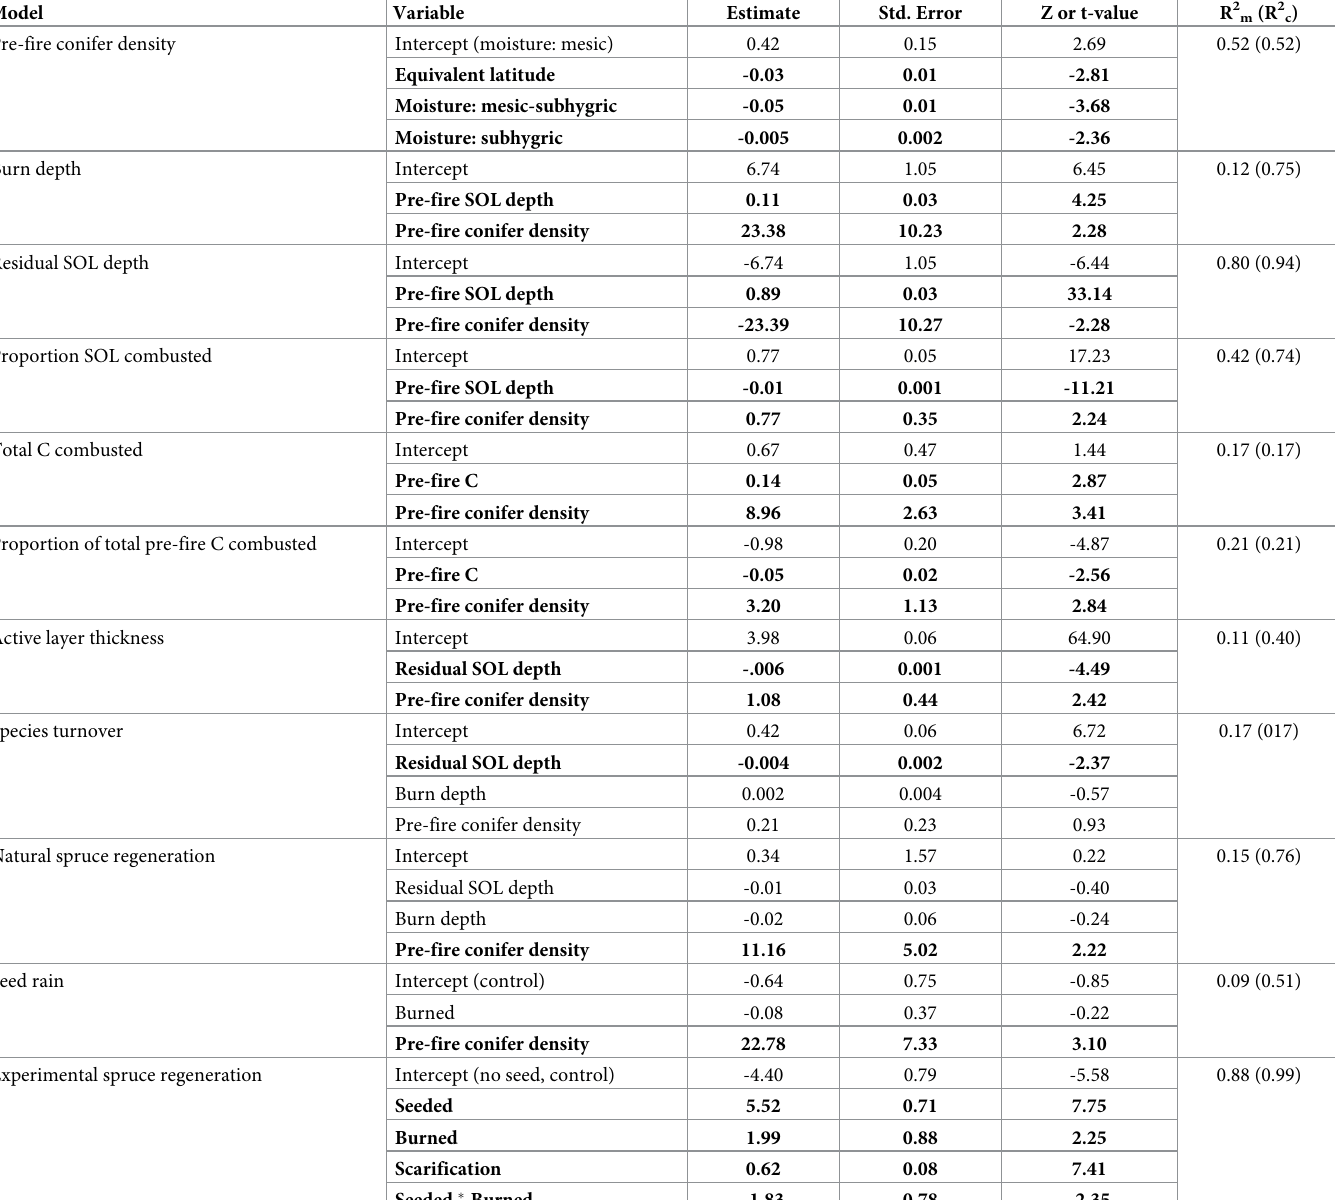
Table 2. The effects of environmental variables, landscape characteristics, wildfire severity, and pre-fire tree density on post-fire changes in ecosystem structure and